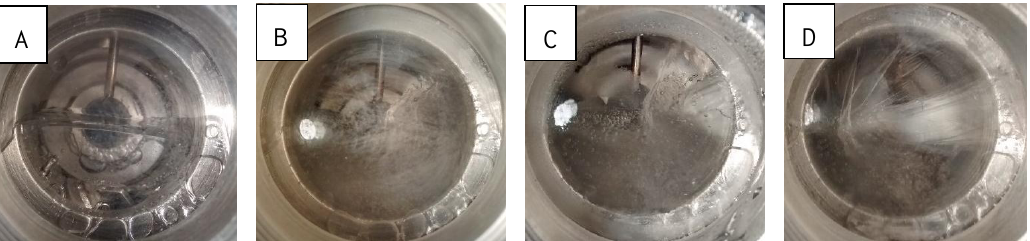
-L CO ); ( B ) just after incipient formation start 2 O 2 -L CO ); ( D ) ca. 170 min after formation 2 O 2